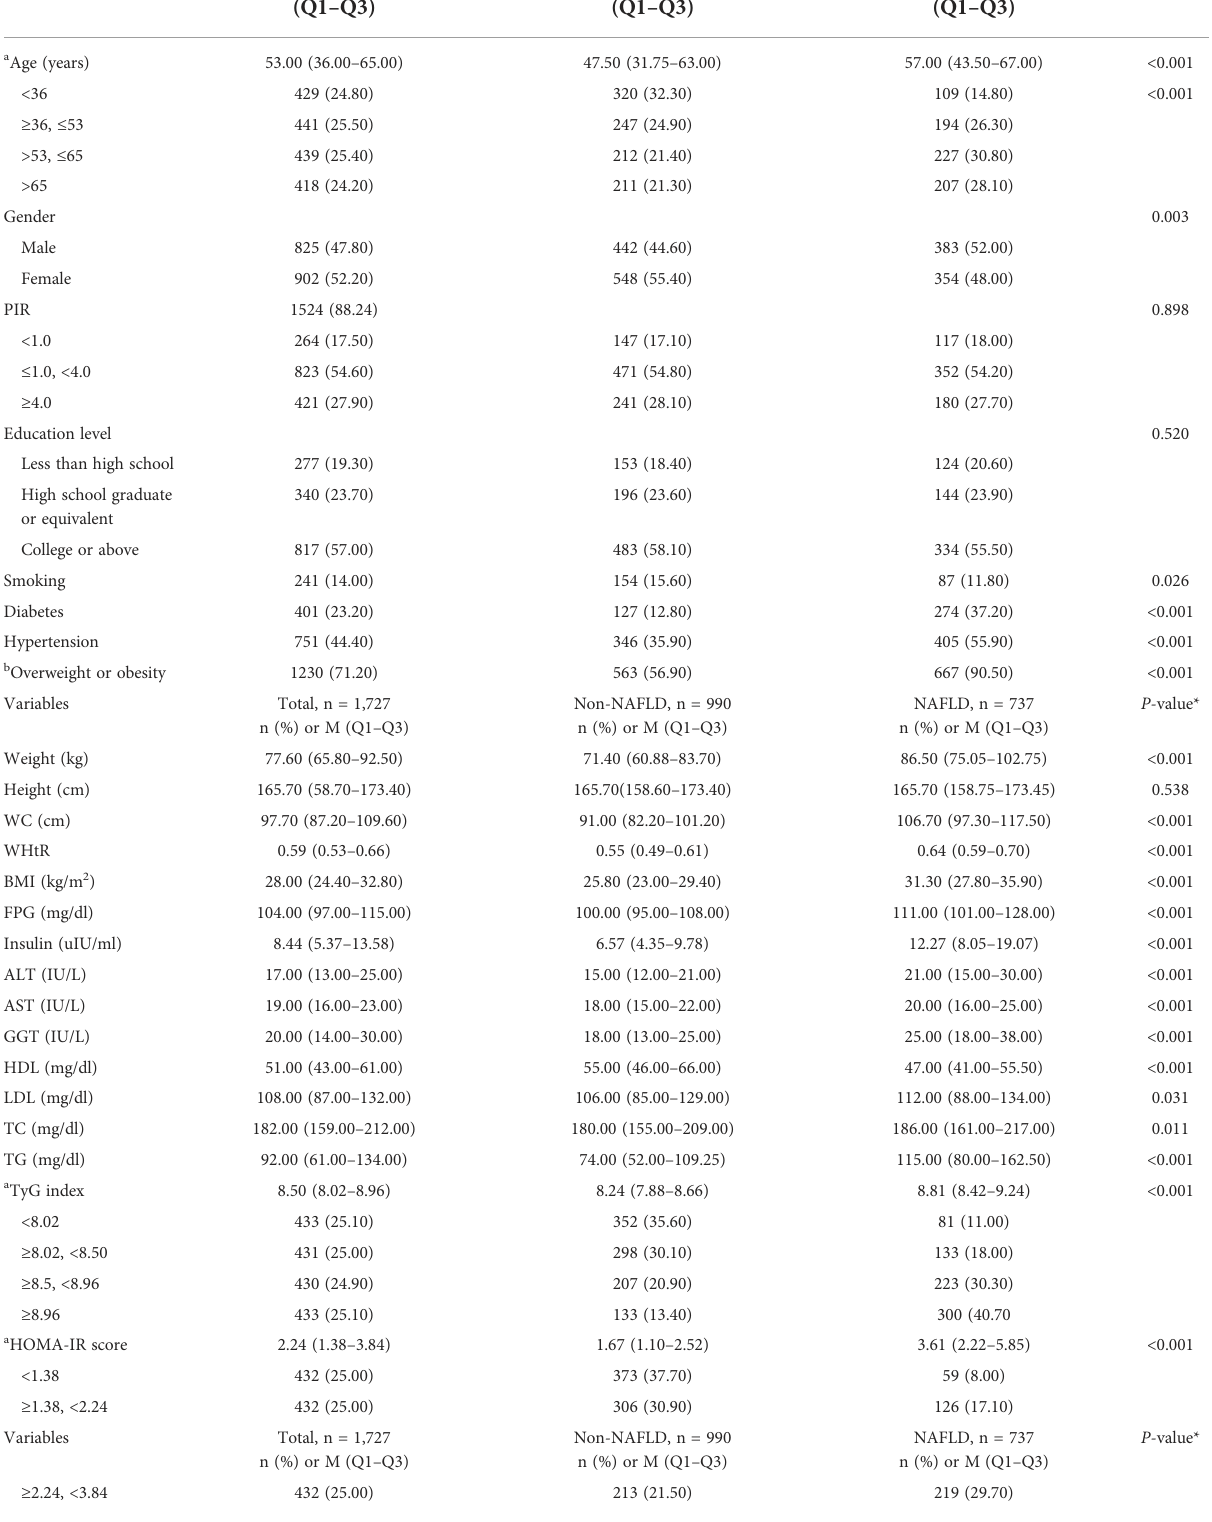
TABLE 1 Baseline clinical and biochemical characteristics of the